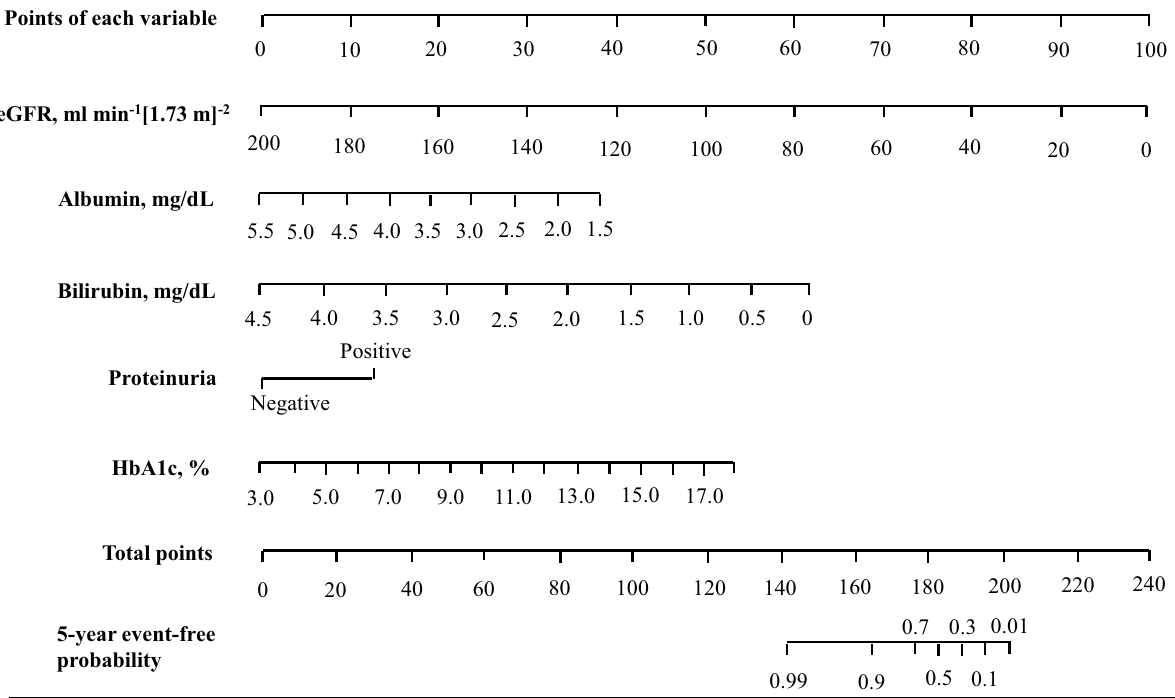
Figure 2. Nomogram for end-stage kidney disease (ESKD)-free event probabilities of individuals with diabetes. To use the nomogram. Locate an individual’s value on each variable axis, and draw a line upward to obtain the point for each variable. Then, locate the sum of these points on the total points axis, and draw a line downward to the event-free axis to obtain the 5-year ESKD-free probability. eGFR estimated glomerular filtration rate, HbA1c hemoglobin